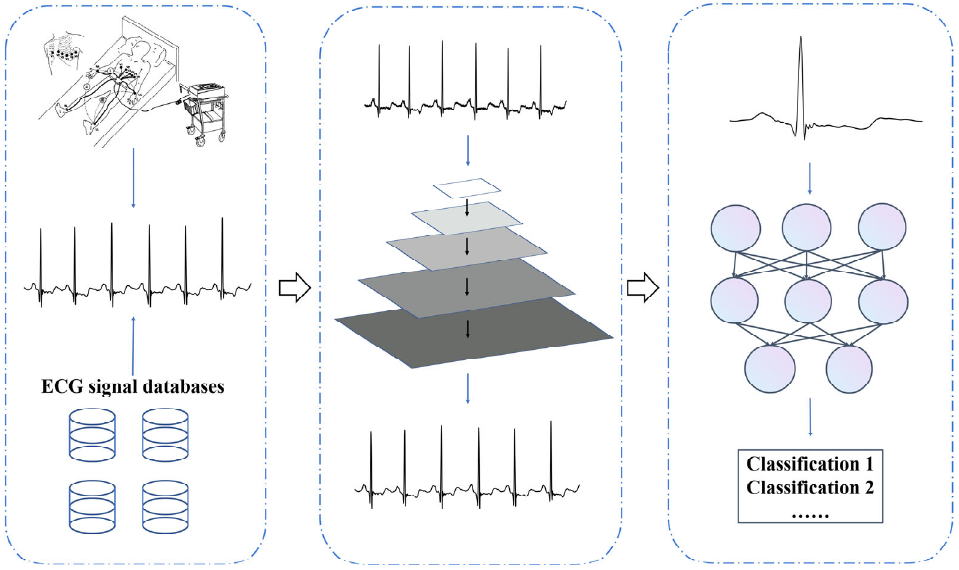
Figure 4. Detailed flow chart of ECG signal processing.